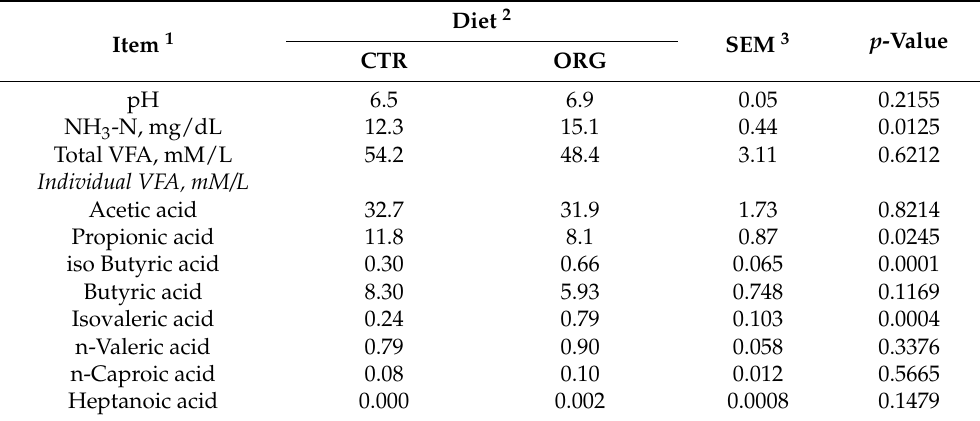
Table 4. Ruminal parameters: pH, NH 3 -N, and volatile fatty acids (VFA) of Murciano-Granadina dried goats ( n = 10) by the type of diet. Item 1